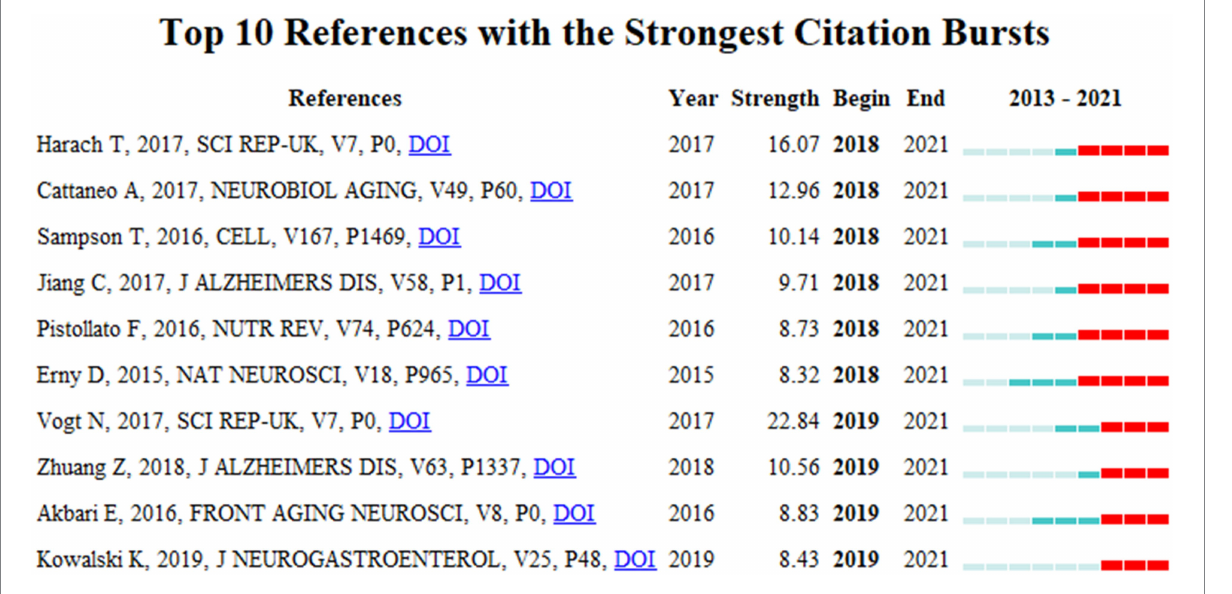
FIGURE 10 References with the strongest citation bursts from 2013 to